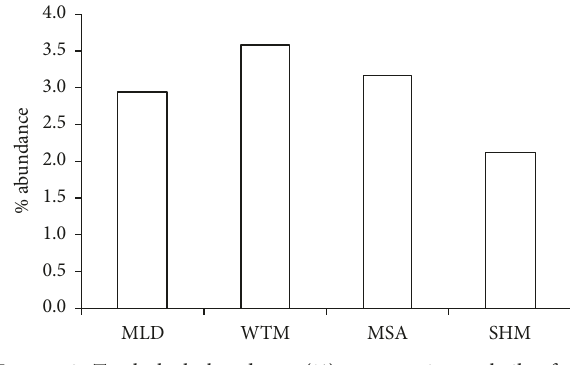
Figure 2: Total algal abundance (%) on experimental tiles from four Kenyan protected reef coral lagoons (MLD: Malindi; WTM: